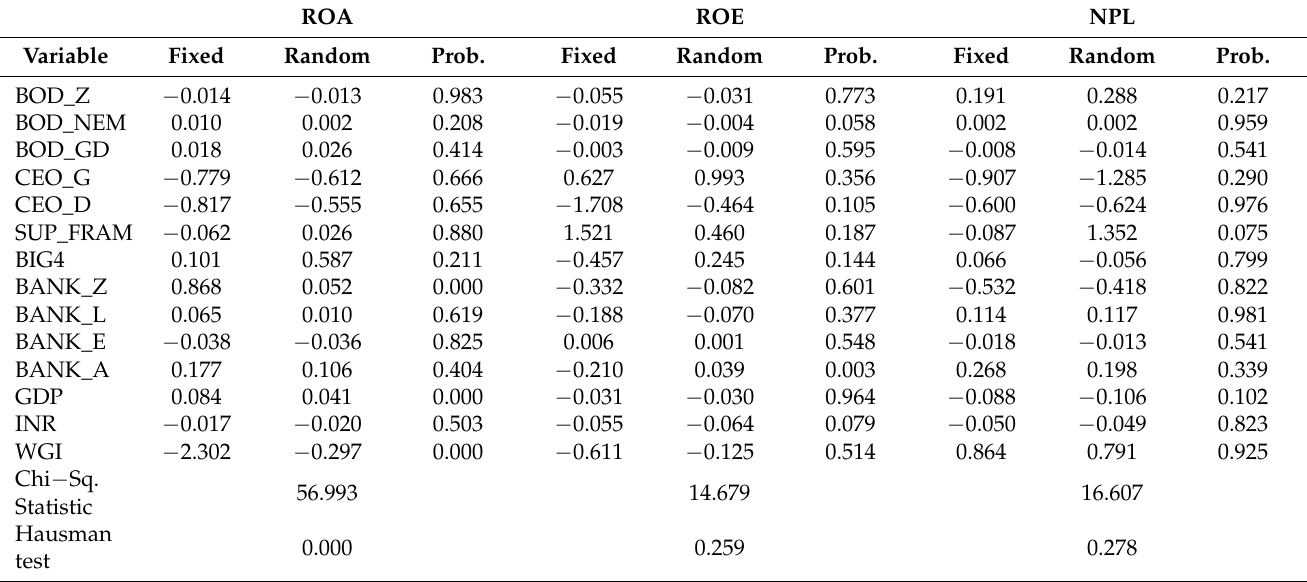
Table A4. Hausman test—Conventional